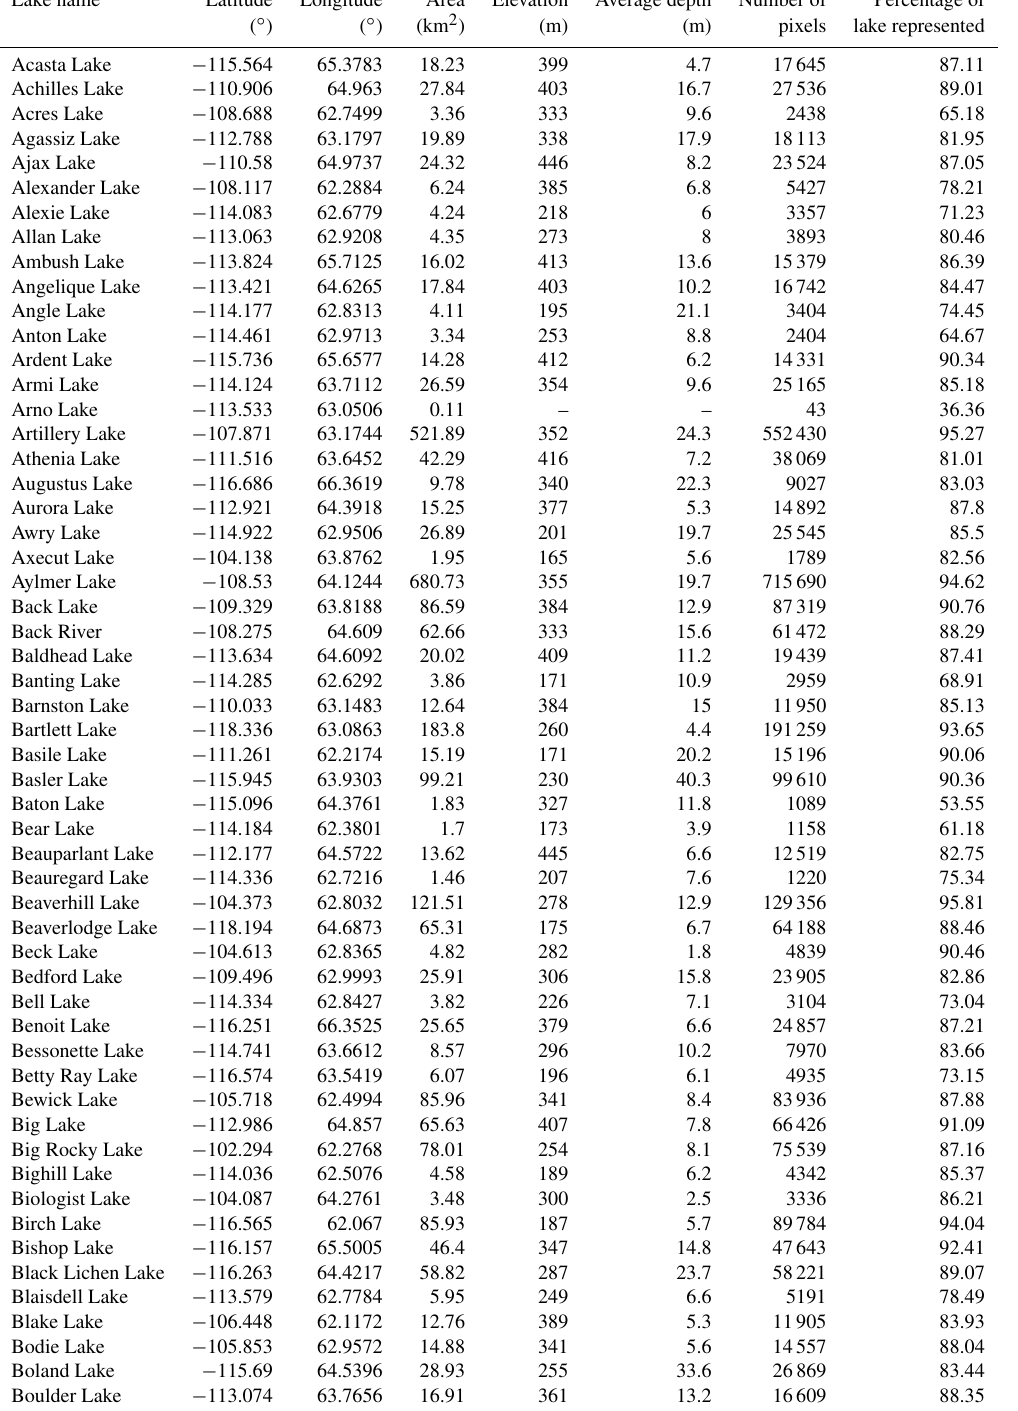
Table A1. Properties of selected lakes in the North Slave